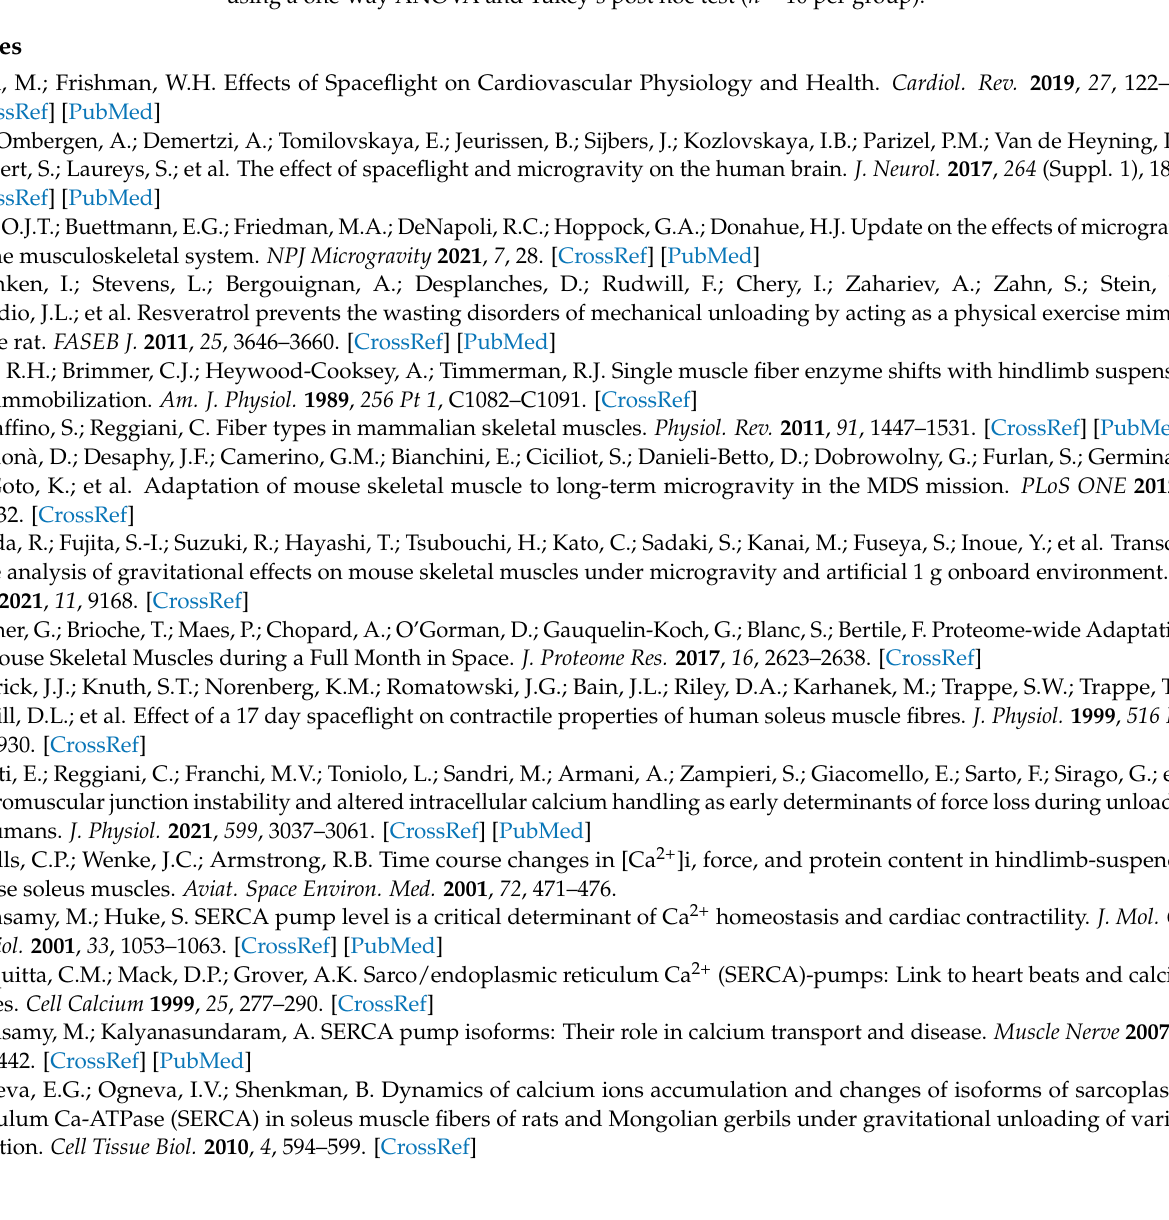
Figure A2. Body mass ( A ), soleus/body mass ( B ), and TA/body mass ( C ) data from flight, GC, and VIV groups from the RR9 mission. All values are means ± SEM. Values above bars indicate p -values using a one-way ANOVA and Tukey’s post hoc test ( n = 10 per